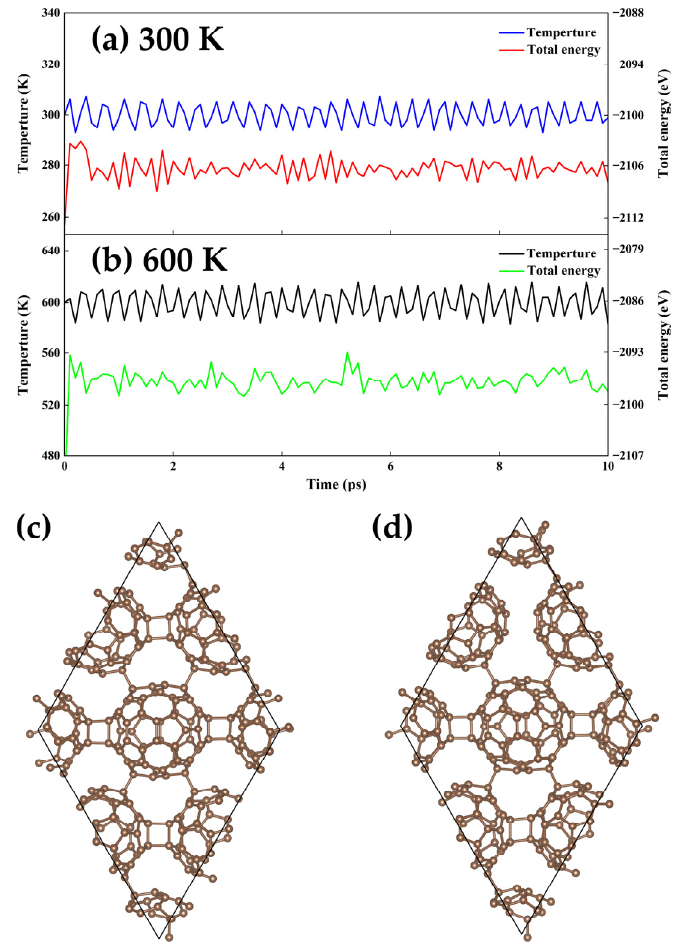
Figure 4. Total energy (left) and temperature (right) of qhp-C 60 at ( a ) 300 K and ( b ) 600 K. The snapshot of the configuration at time of 10 ps and temperature of 300 K ( c ) and 600 K ( d ).